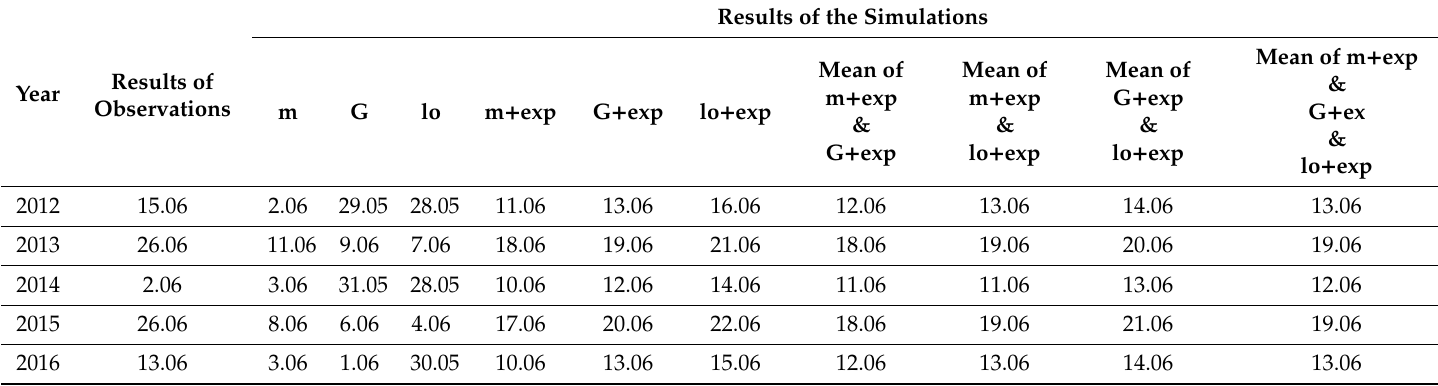
Table 10. Comparison of the observed beginning of oilseed rape maturation and simulated with the use of models listed in Table 2.